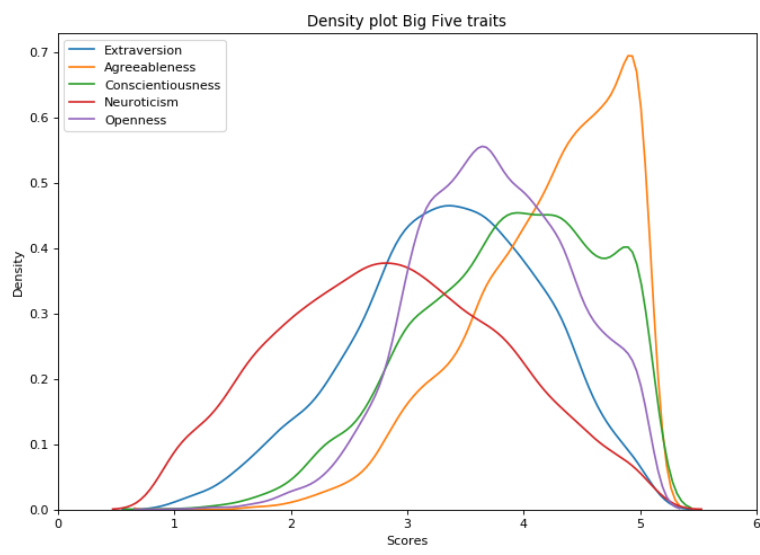
Figure 3. Distribution of scores on the Big Five traits in our sample of 6408